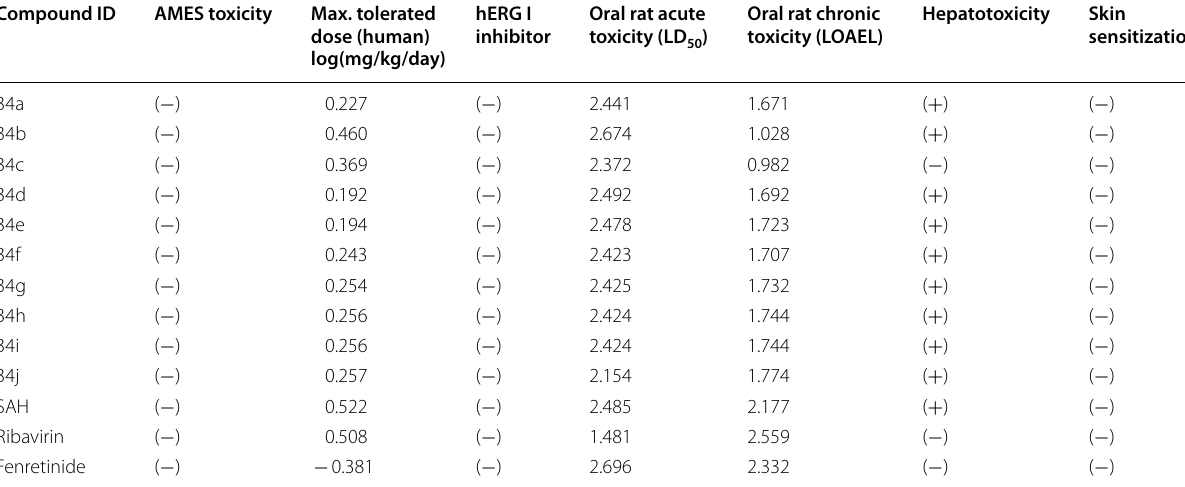
Table 5 Predicted toxicity of the designed